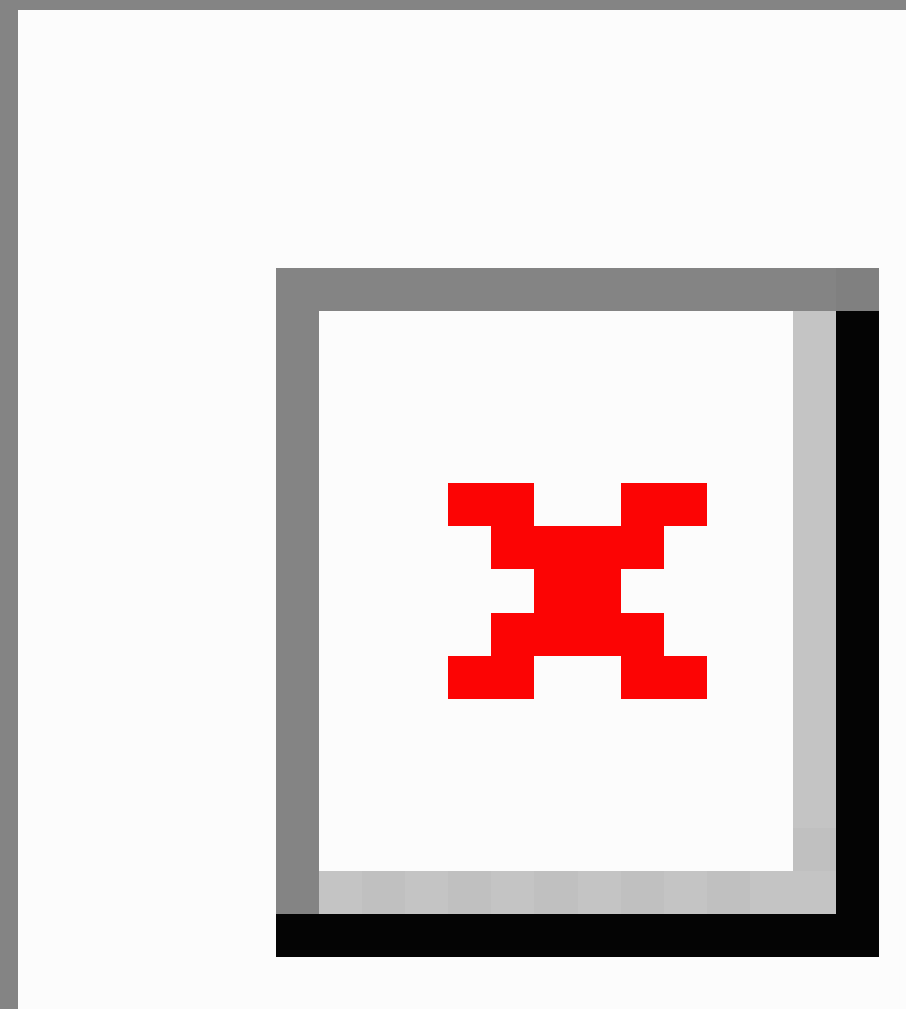
Figure 1. Data collection method for Internet Panel Survey